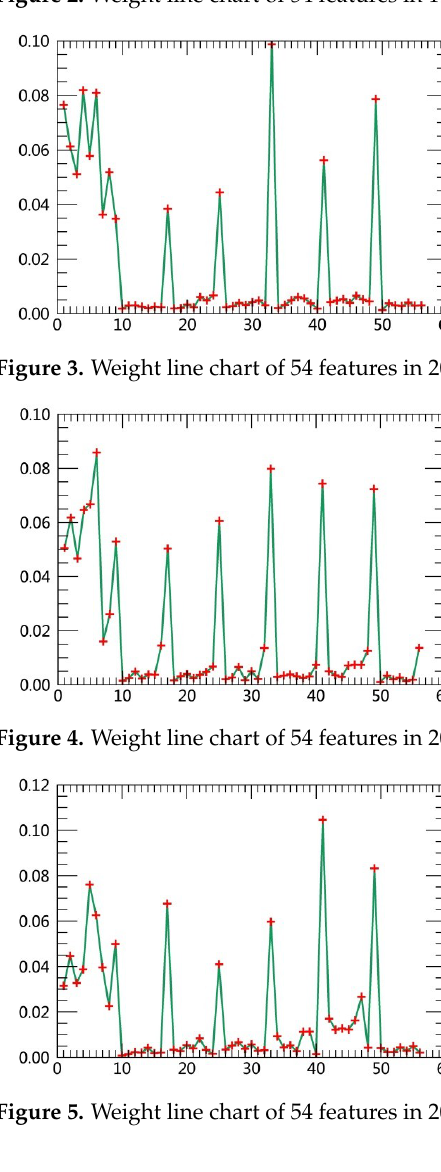
Figure 2. Weight line chart of 54 features in 1995.